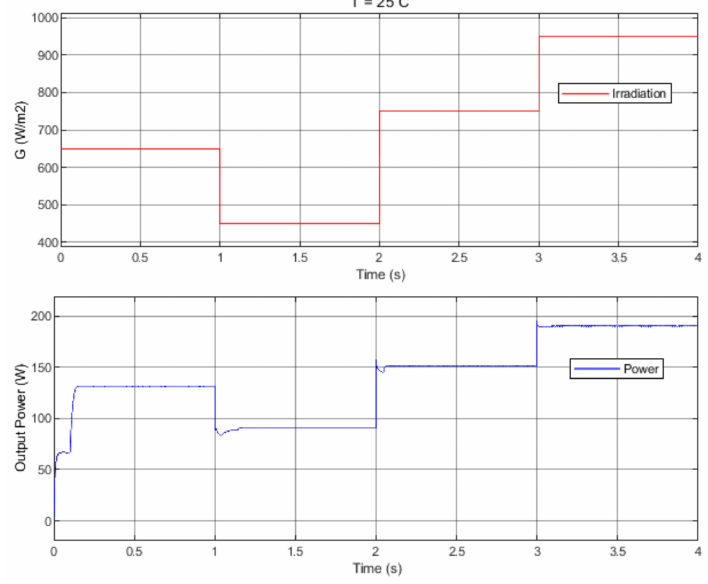
Figure 19. Output powers under the change of